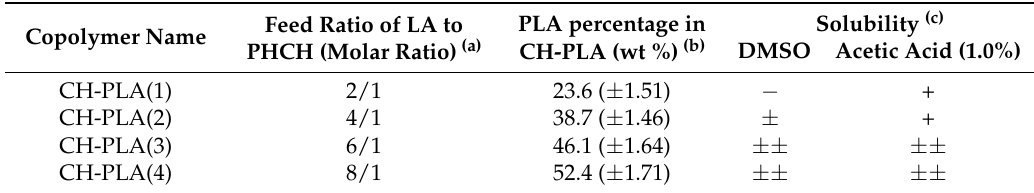
Table 1. Parameters of CH-PLA copolymers ( n =